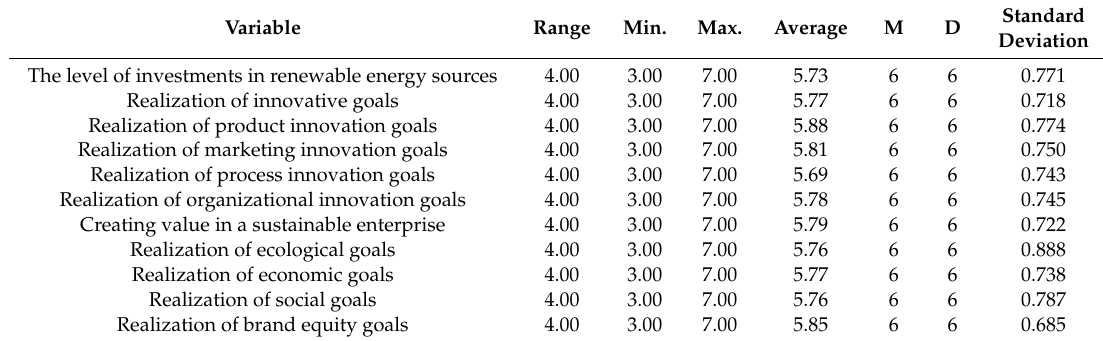
Table 3. Descriptive statistics of the variables examined (N = 143).